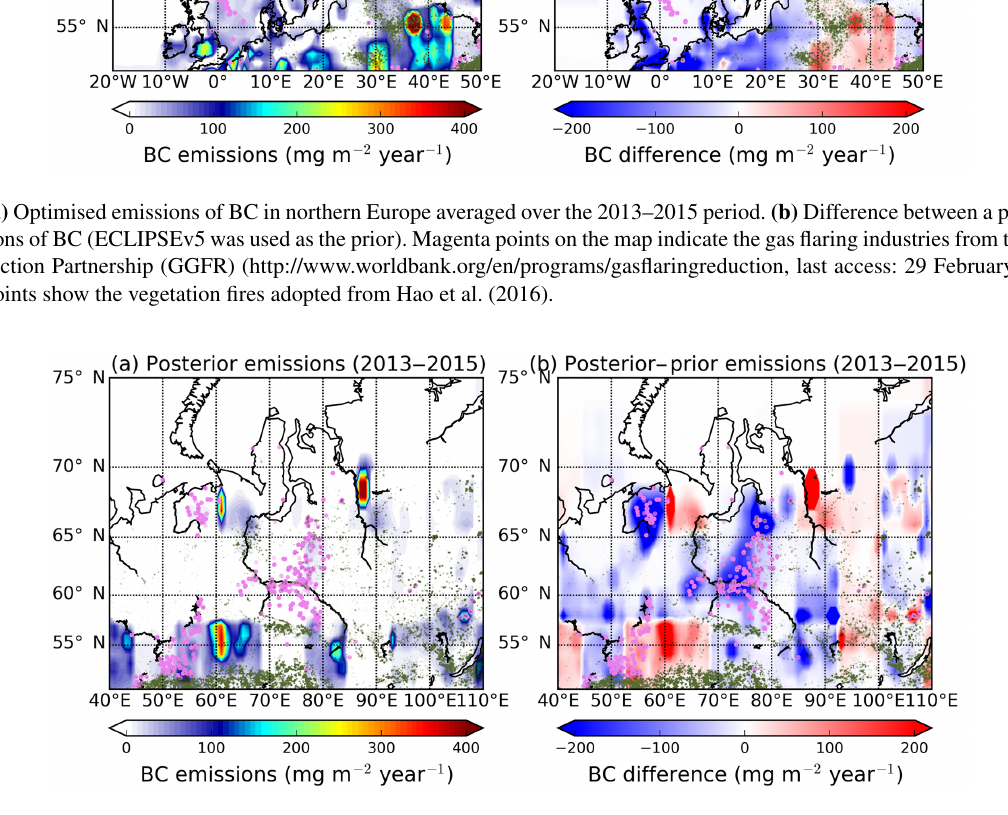
Figure 12. (a) Optimised emissions of BC in western Siberia averaged for the 2013–2015 period. (b) Difference between a posteriori and a priori emissions of BC (ECLIPSEv5 was used as the prior). Magenta points on the map indicate the gas flaring industries from the Global Gas Flaring Reduction Partnership (GGFR) (http://www.worldbank.org/en/programs/gasflaringreduction, last access: 29 February 2017), while dark green points show the vegetation fires adopted from Hao et al.